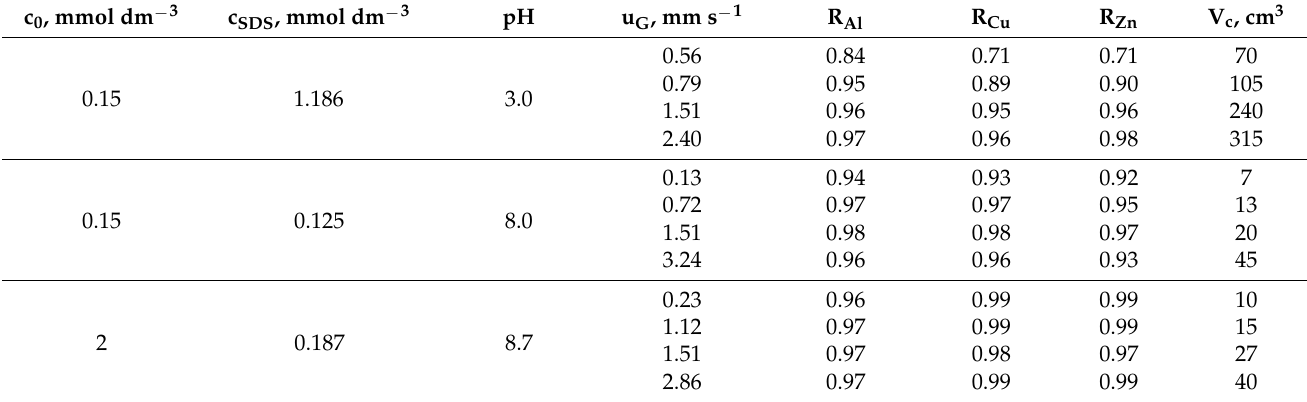
Table 6. Effect of the air velocity on the efficiency of simultaneous ion or precipitate flotation of Al(III), Cu(II) and Zn(II) mixture. c 0 , mmol dm −